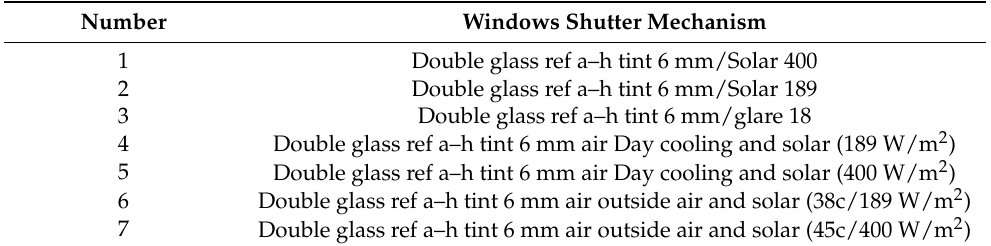
Table 6. Windows shutter control mechanism.